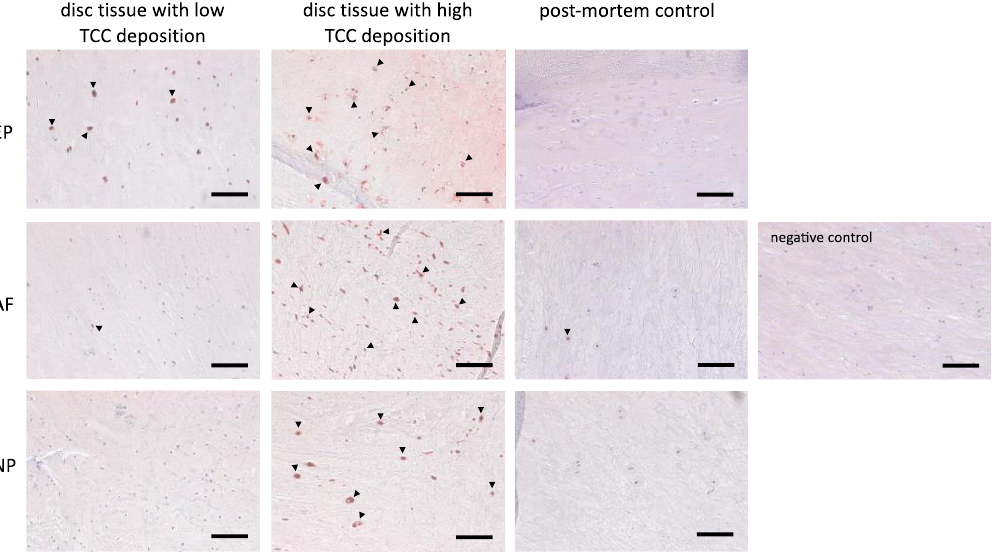
One-way ANOVA was used.